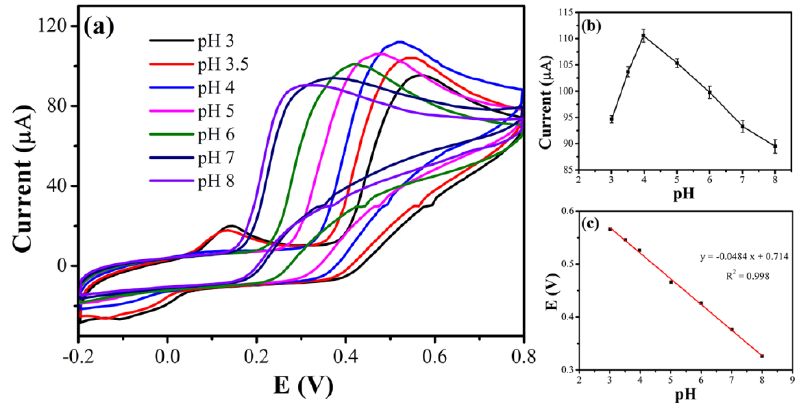
Figure 7. ( a ) CVs of Bi 2 S 3 /rGO-3/GCE in the presence of 5 mM AA comprising of various pH solutions from 3 to 8 at a scan rate of 100 mV s −1 ; ( b ) The plot of I P vs. pH value, and ( c ) E P vs. pH value.